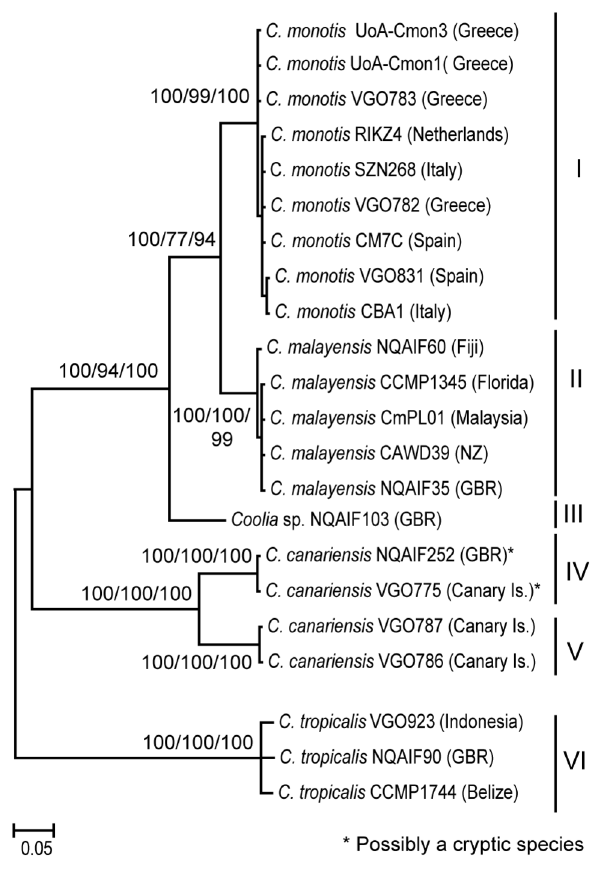
Figure 1. Phylogeny of the genus Coolia based on available 28S rRNA gene sequences. Six distinct clades are identified (Roman numerals). Branch labels indicate Bayesian clade credibility values, and MP and ML bootstrap support, respectively. The tree was midpoint rooted. Scale bar represent number of changes.